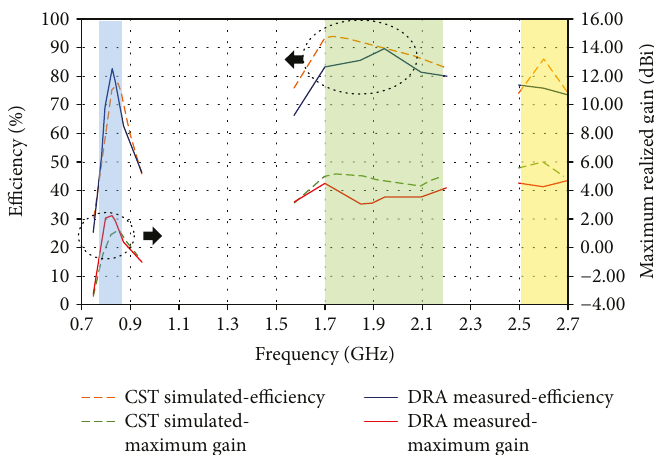
Figure 12: Measured and simulated maximum realized gains and total e ffi ciencies for the proposed DRA.